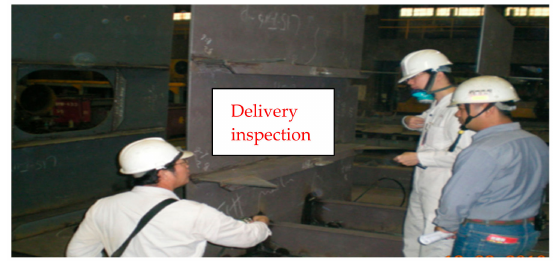
Figure 17. Delivery inspection by the shipowner and team.